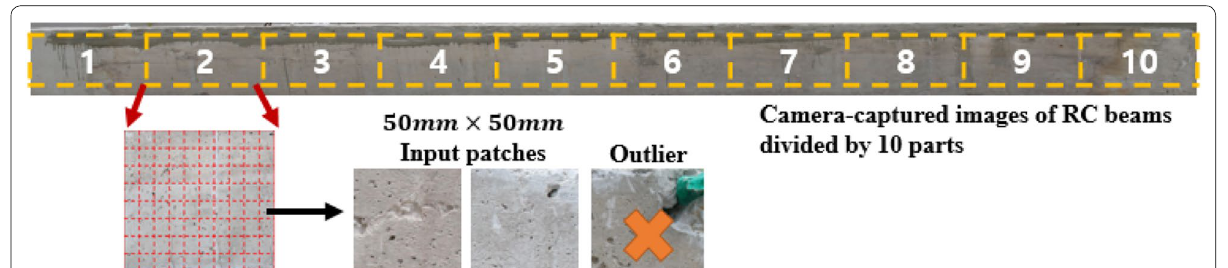
Fig. 4 Image data acquisitions and